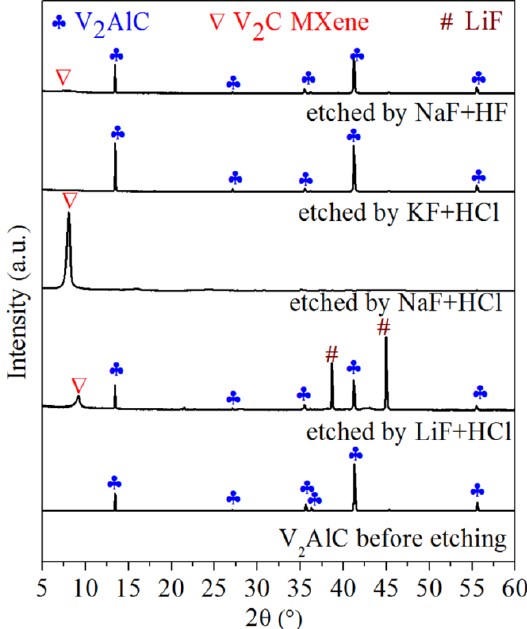
Figure 1. XRD patterns of V 2 AlC samples before and after the etching in different solutions.